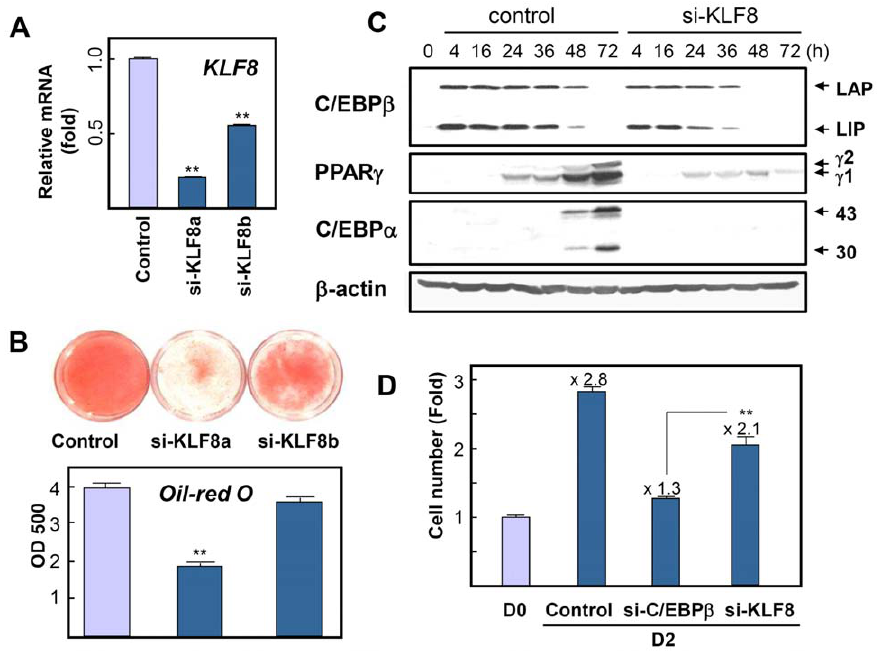
Figure 2. KLF8 knockdown blocks 3T3-L1 adipocyte differentiation. Preadipocyte 3T3-L1 cells were treated with KLF8 siRNA at about 70% confluence using Lipofectamine RNAi/MAX reagent. After 24 h, the cells were trypsinized and replated at confluent cell density. After an additional 24 h, the cells were induced to differentiate. (A) Twenty hours after induction, cell extracts were prepared, and the effect on the expression of KLF8 was analyzed by real-time RT-PCR. (B) Oil red-O staining on day 8. The low panel represents spectrophotometric count of staining from 3 independent experiments. (C) Cells were harvested at the indicated times, and cell lysates were separated by SDS-PAGE and immunoblotted with antibody against C/EBP b , PPAR c , and C/EBP a . LAP, liver-activating protein, LIP, liver-inhibitory protein, PPAR c 1, PPAR c 2, and 43 or 30 kDa of C/EBP a proteins were indicated. (D) To investigate the effect of siRNA on mitotic clonal expansion, cell numbers were determined at day 0 or day 2 after induction. Fold increases compared to the cell number in D0 were marked. Data in (A), (B), and (D) represent the mean 6 SD. ** P , 0.01.